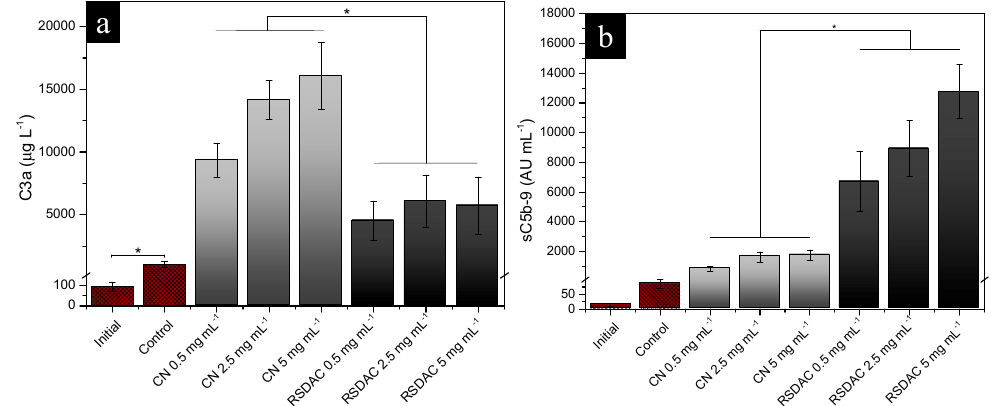
Figure 4. Levels of: ( a ) C3a; ( b ) sC5b-9 complexes after whole blood incubation with Cladophora nanocellulose (CN) and RSDAC at 37 °C for 60 min. Data represent mean ± standard error of the mean for n = 8. Statistically significant differences between sample groups are indicated by * ( p < 0.05). All Cladophora nanocellulose and RSDAC values were significantly different from the initial sample and control.